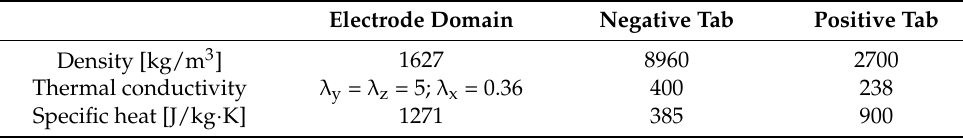
Table 3. Specifications of various domains of 2300 F Lithium-ion